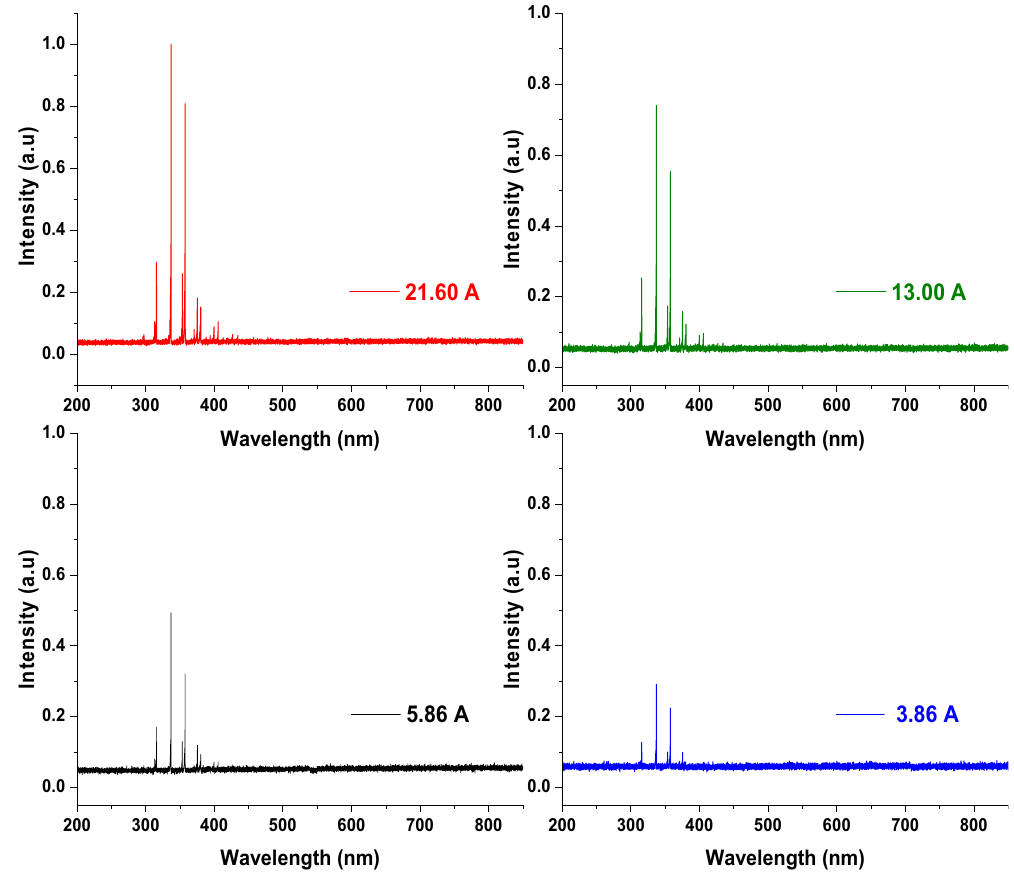
Figure 3. Emission spectra of large volume air plasma at different discharge currents and fixed operating conditions of 2000 Hz and 15 mm discharge gap.